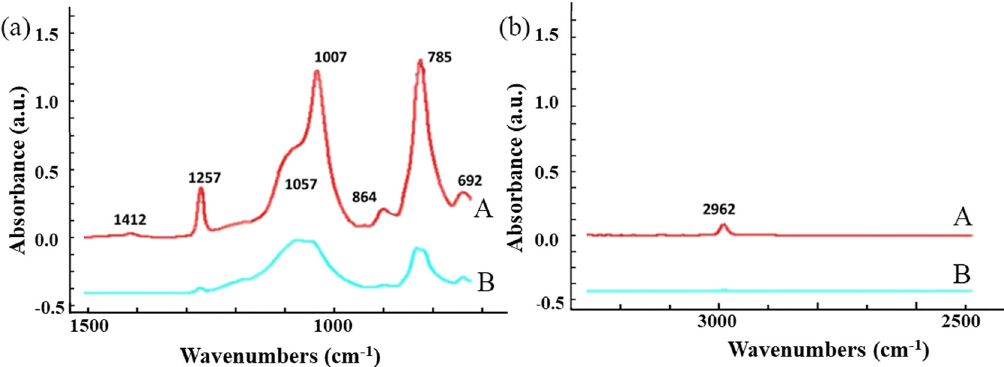
Figure 3: IR spectra for ( A ) unexposed specimens and ( B ) aged specimens in ADT solution for 33 days at 70°C. ( a ) Wavenumbers from 650 to 1,500 cm − 1 and ( b ) wavenumbers from 2,500 to 3,500 cm − 1